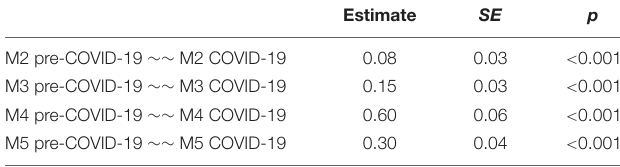
TABLE 3 | Unstandardized latent change score model